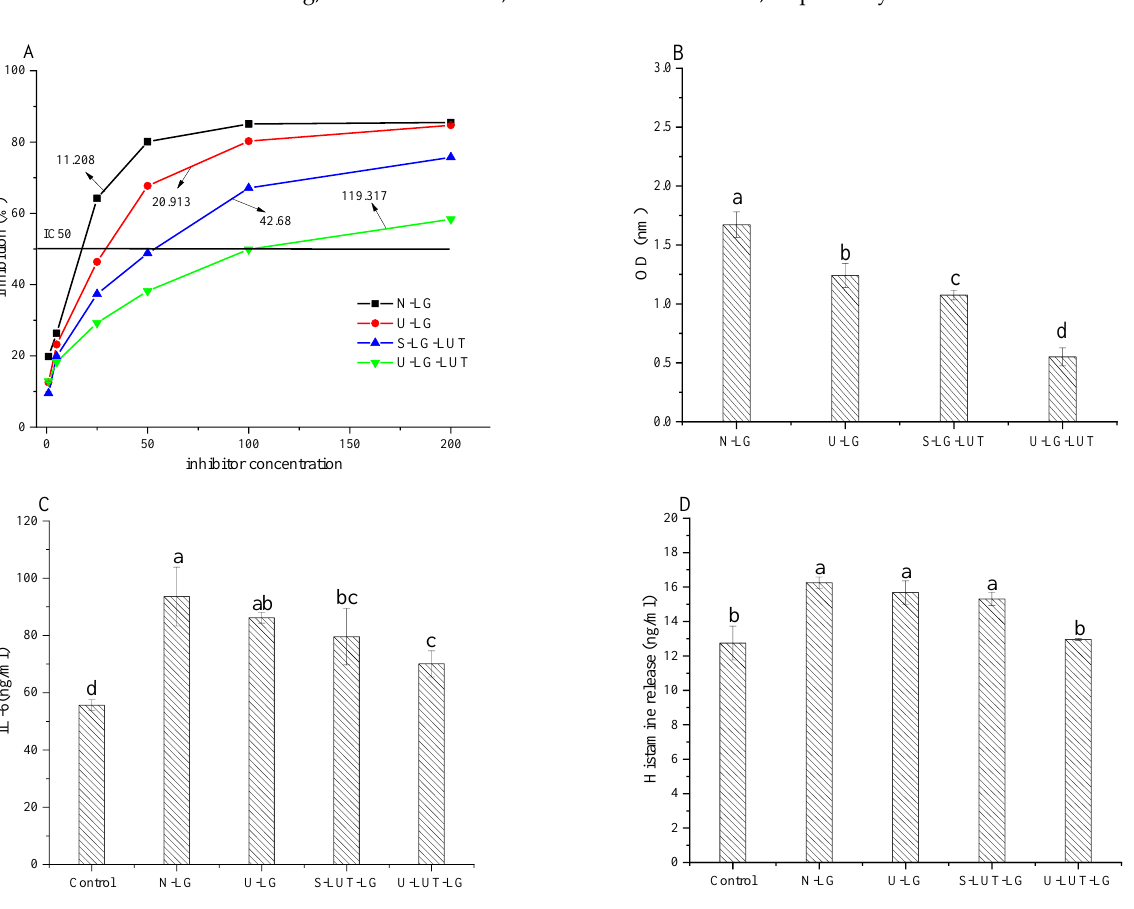
Figure 2. Binding interactions and 2D interaction diagrams of LUT binding with β -LG. The 3D interaction mode of β -LG and LUT( A ), and the 2D plan view of the interaction between β -LG and LUT( B ). In the 2D plan view, light green circles correspond to amino acid residues that interact with the LUT through van der Waals forces. Green, purple, and orange dashed lines represent hydrogen bonding, π - π accumulation, and π -cation interactions, respectively.